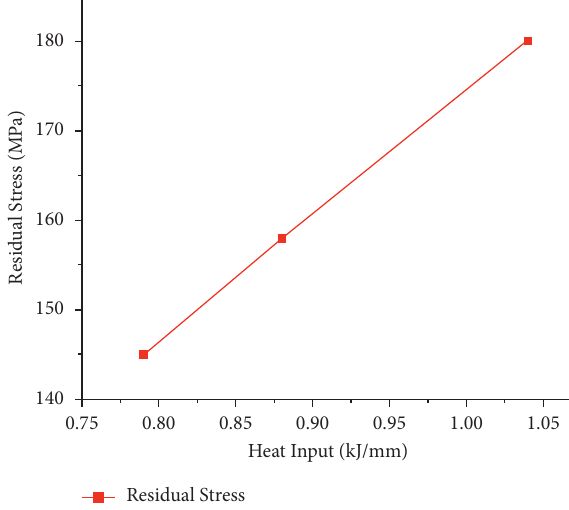
Figure 6: Residual stresses as a function of heat input.